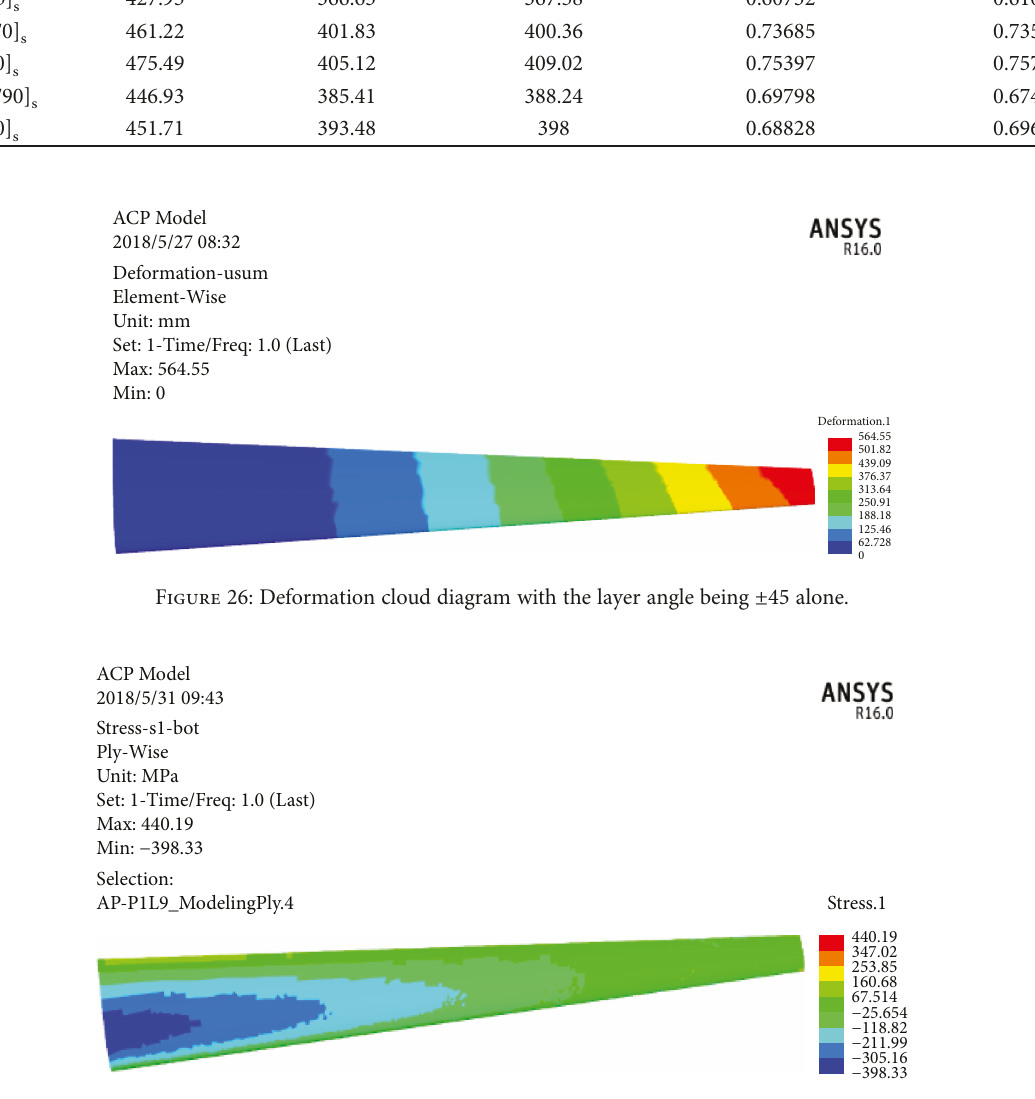
Figure 27: Stress cloud diagram of the upper wing with the layer angle being ± 45